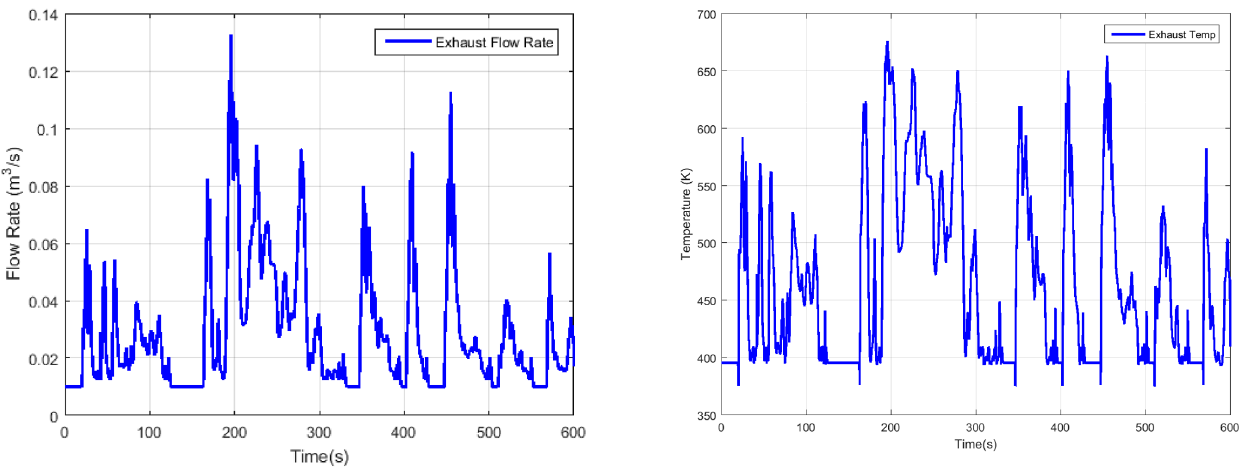
Fig 3. Exhaust flow rate and exhaust temperature during the FTP-75 test cycle